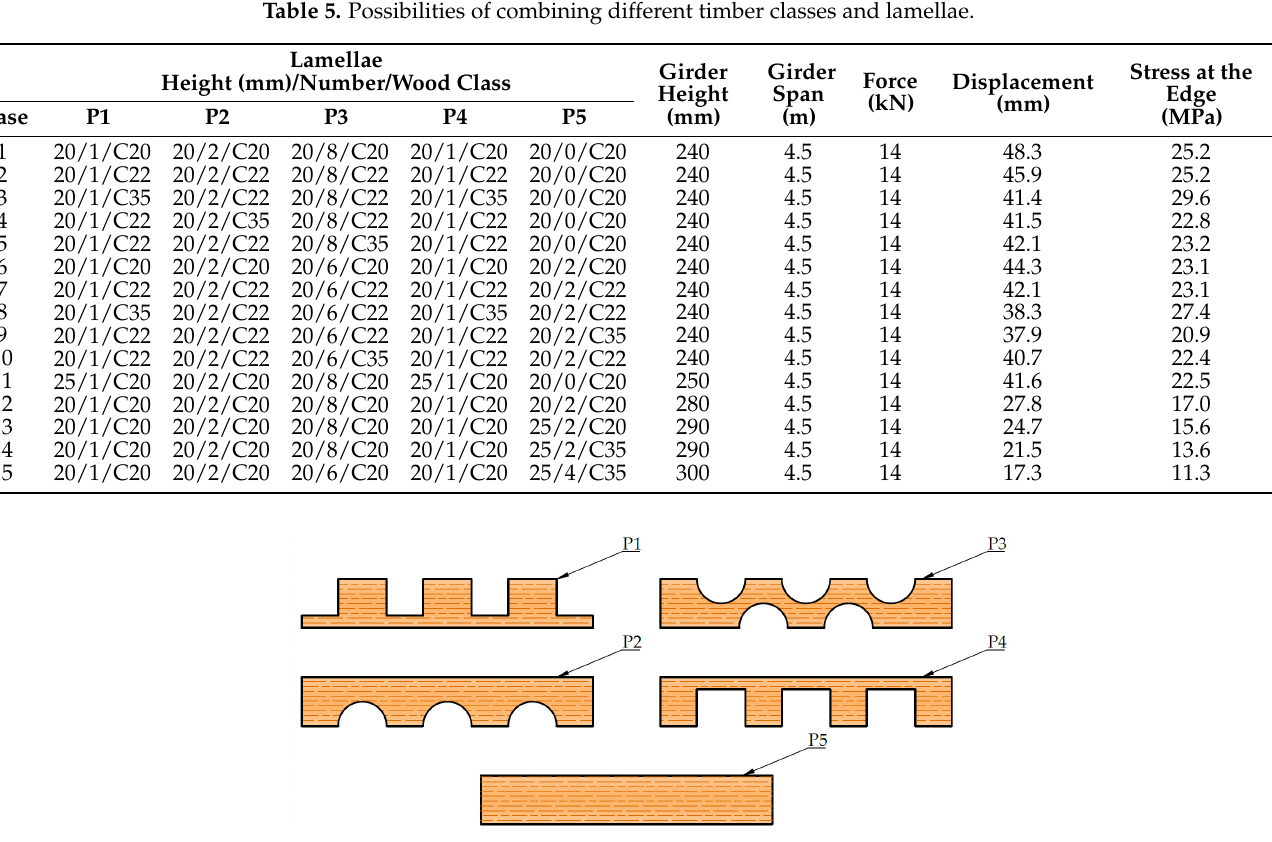
Figure 33. Lamella types.